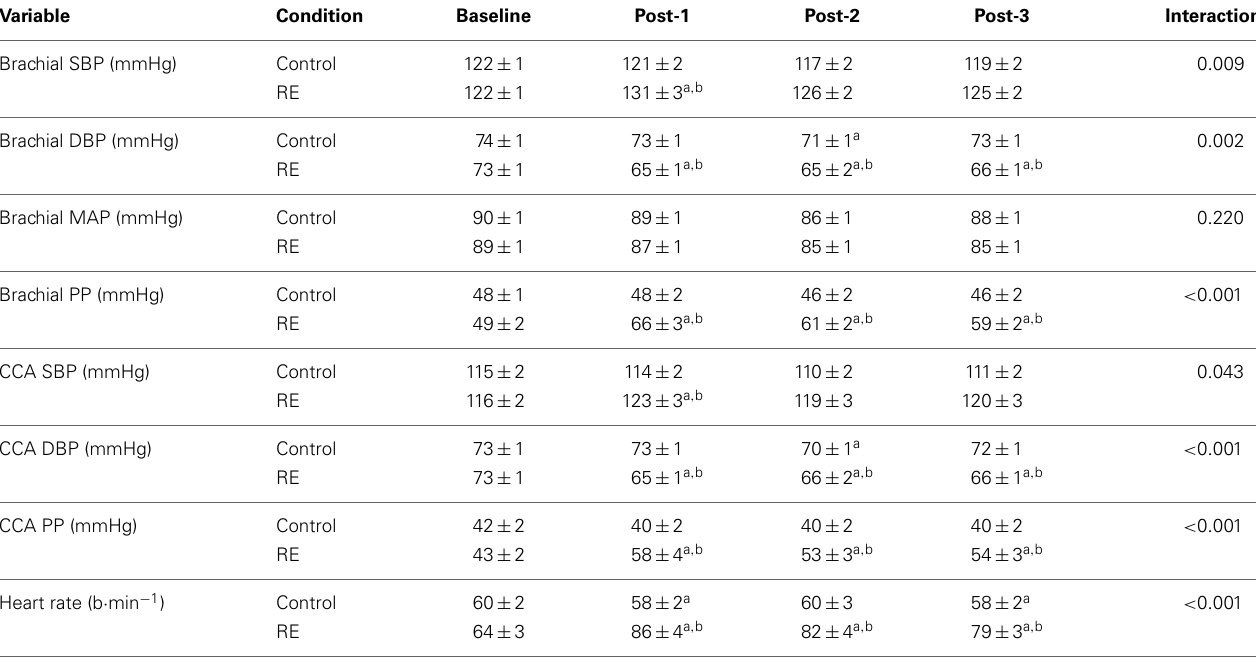
Table 1 | Common carotid artery (CCA) and brachial pressures across testing time points between control and resistance exercise ( n = 18). Variable